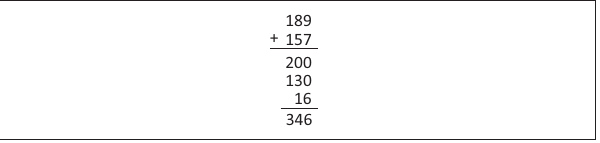
FIGURE 6: Example of ‘Write all totals’ or partial sums algorithm in Everyday Mathematics